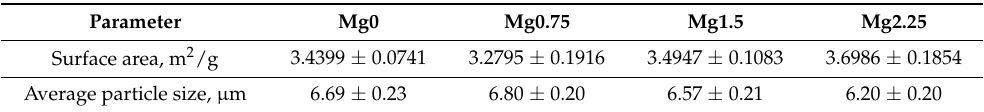
Table 2. Surface area and average particle size of Mg x Ca 3 − x (PO 4 ) 2 powders for Mg0, Mg0.75, Mg1.5, and Mg2.25.